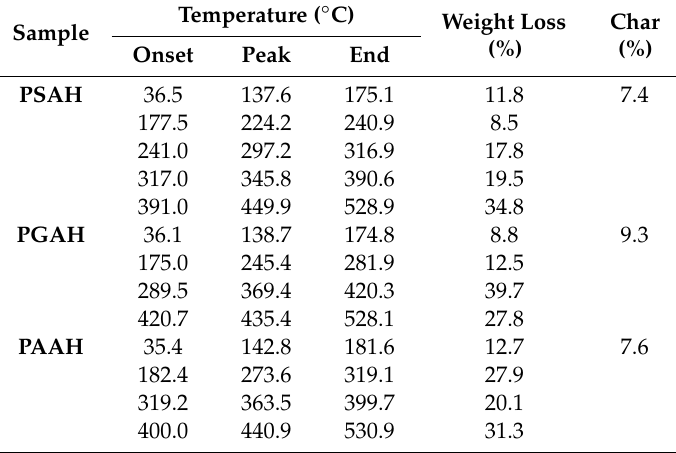
Figure 4. TG ( A ) and DTG ( B ) curves of the PSAH, PGAH, and PAAH recorded at 10 °C/min in the N 2 atmosphere. Table 3. Thermogravimetric analysis results from hydrogels.